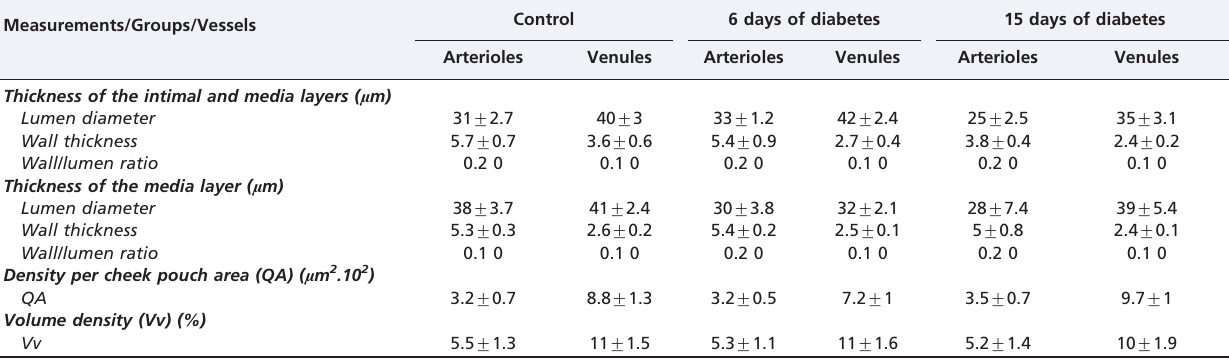
Table 1 - Morphological and stereological measurements of microcirculatory vessels of age-matched control and diabetic